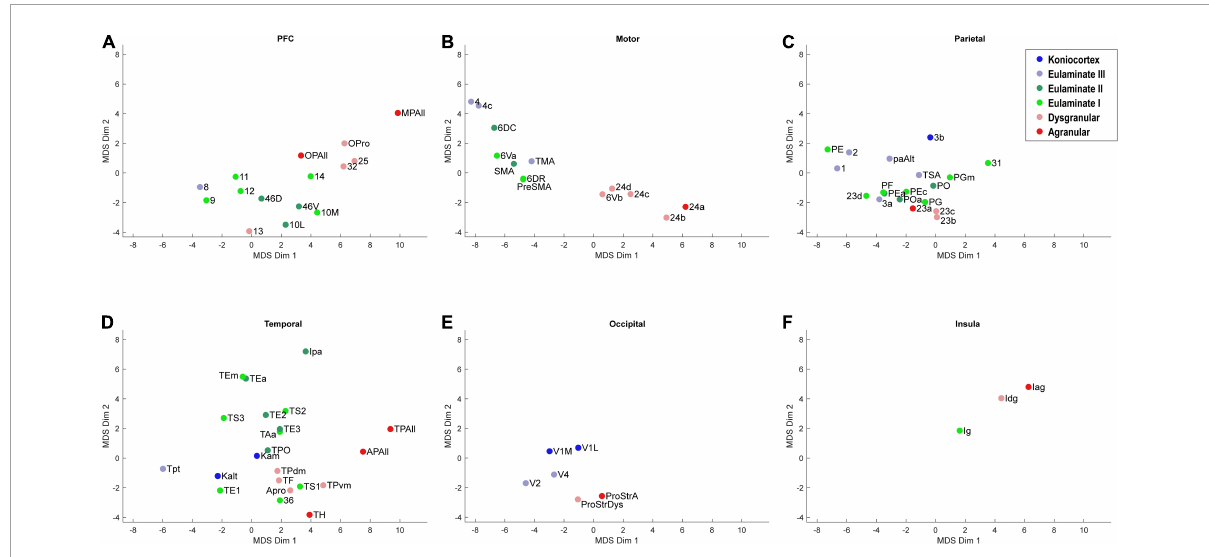
FIGURE4 Scatter plot of 78 cortical areas in MDS-derived dimensions, divided by cortical system. Only the first two dimensions are plotted. (A) Prefrontal cortex, (B) Motor cortex, (C) Parietal cortex, (D) Temporal cortex, (E) Occipital cortex, (F) Insular cortex. Due to overlap of data points, area labels were omitted from some of the